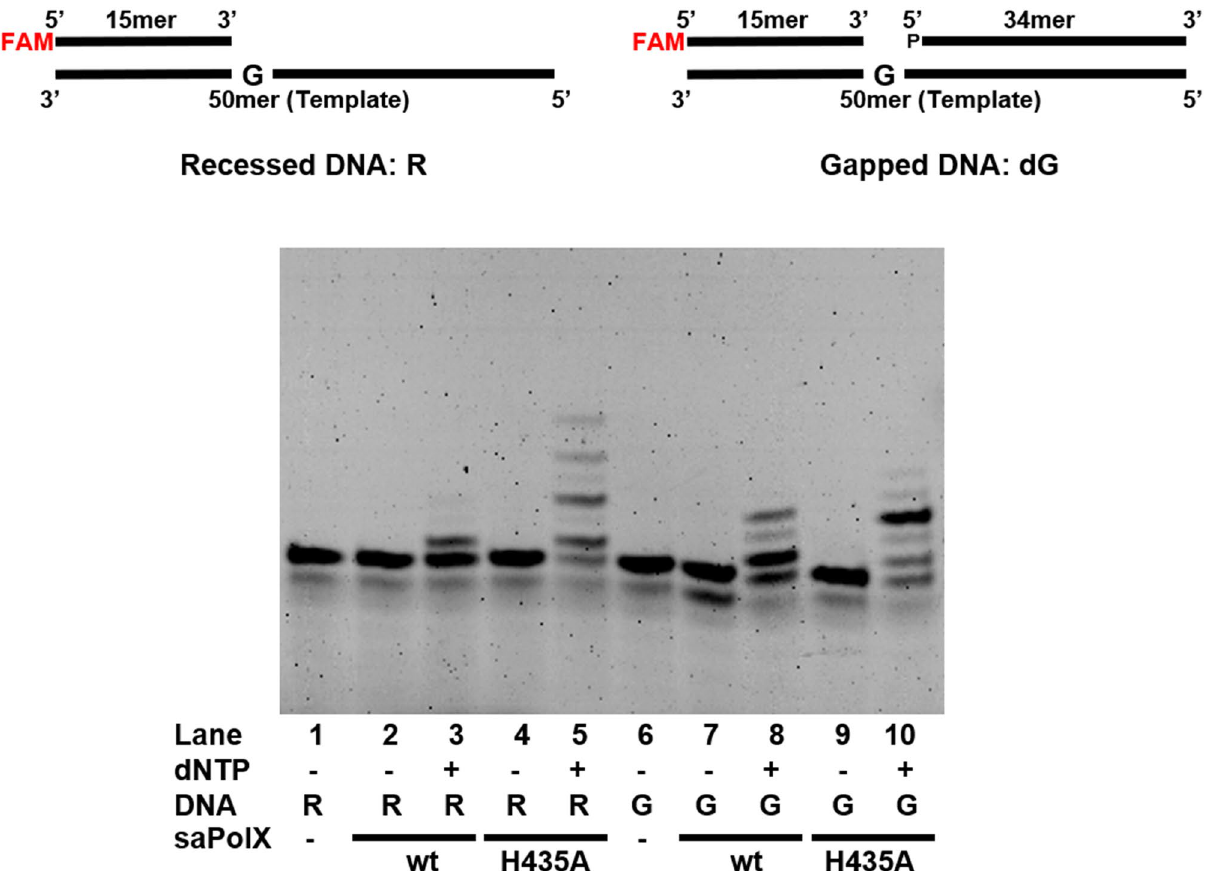
Figure 5. Effect of exonuclease activity on polymerase activity of saPolX. Primer extension assays were performed on a recessed (R) and gapped DNA (dG) substrates to check the role of exonuclease activity on restricting the nucleotide insertion by polymerase domain of saPolX. The enzymatic activities were checked on both the DNA substrates with wt-saPolX and H435A mutant. The results show that H435A exo- mutant inserts higher number of nucleotides on both the substrates as compared to the wt-saPolX. The exonuclease activity residing in the PHP domain of saPolX limits the incorporation of nucleotides by the polymerization activity of the polymerase